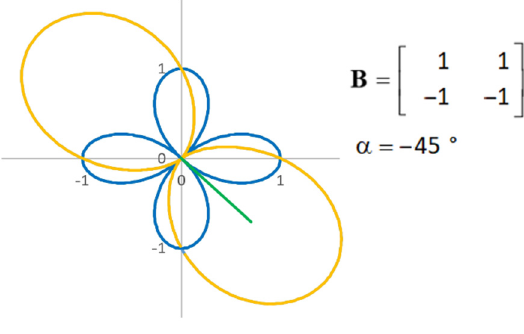
Figure 7. General tensor with 𝛼 = −45° . Figures 7–10 show glyphs representing various general tensor values.